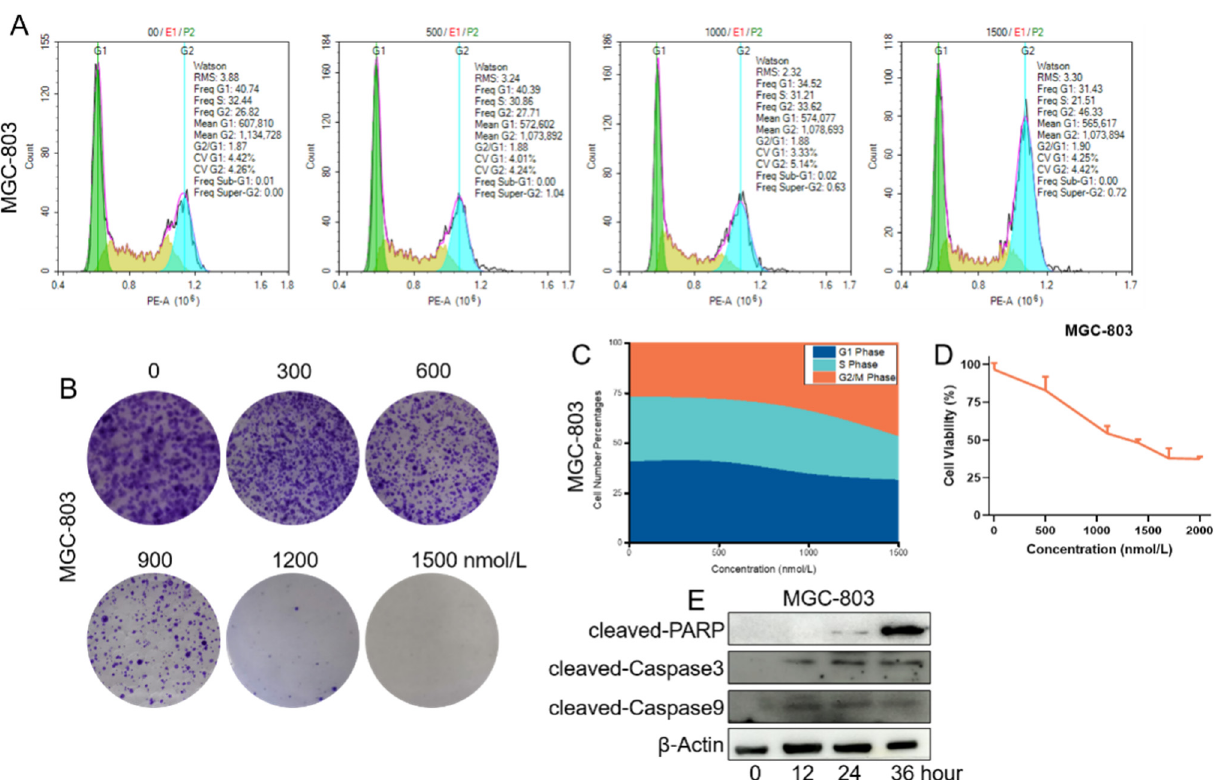
Figure 5. Compound 12e inhibited gastric cancer cells. ( A , C ) Cell-cycle distribution detection, MGC-803 cells were treated with indicated concentrations of compound 12e for 48 h; ( B ) Cell colonies formatted, MGC-803 cells were treated indicated concentrations of compound 12e for 7 d; ( D ) Cell viability of MGC-803 cells, cells were treated indicated concentrations of compound 12e for 48 h; and ( E ) Apoptosis related proteins, MGC-803 cells were treated indicated concentrations of compound 12e for 48 h.